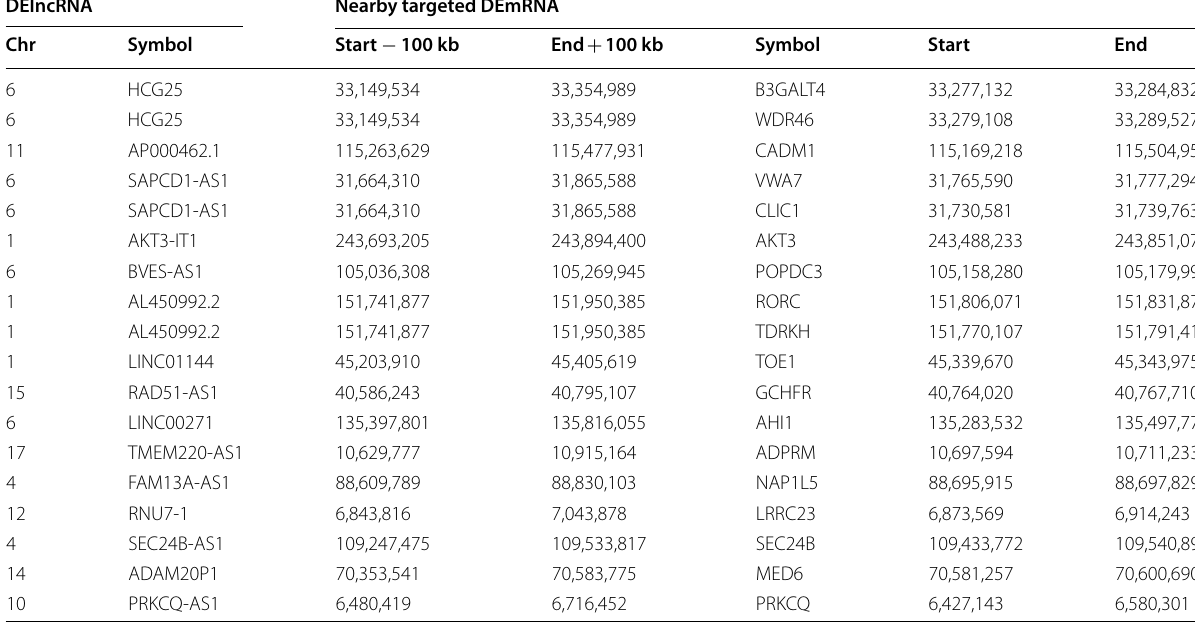
Table 2 Nearby targeted DEmRNAs of